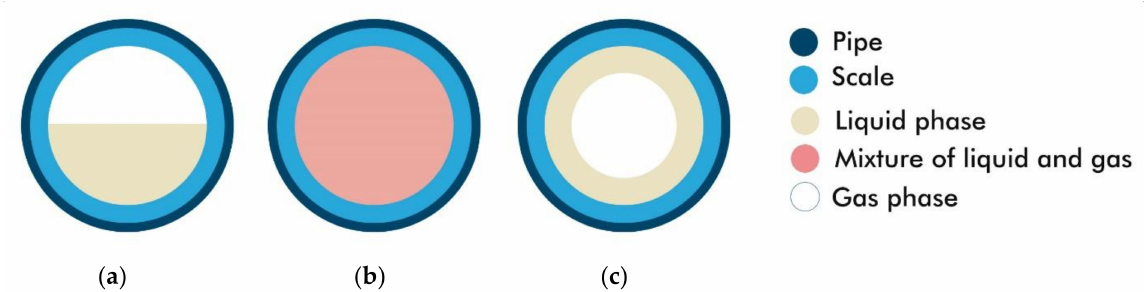
Figure 3. simulated flow regimes ( a ) stratified ( b ) homogeneous ( c ) annular.